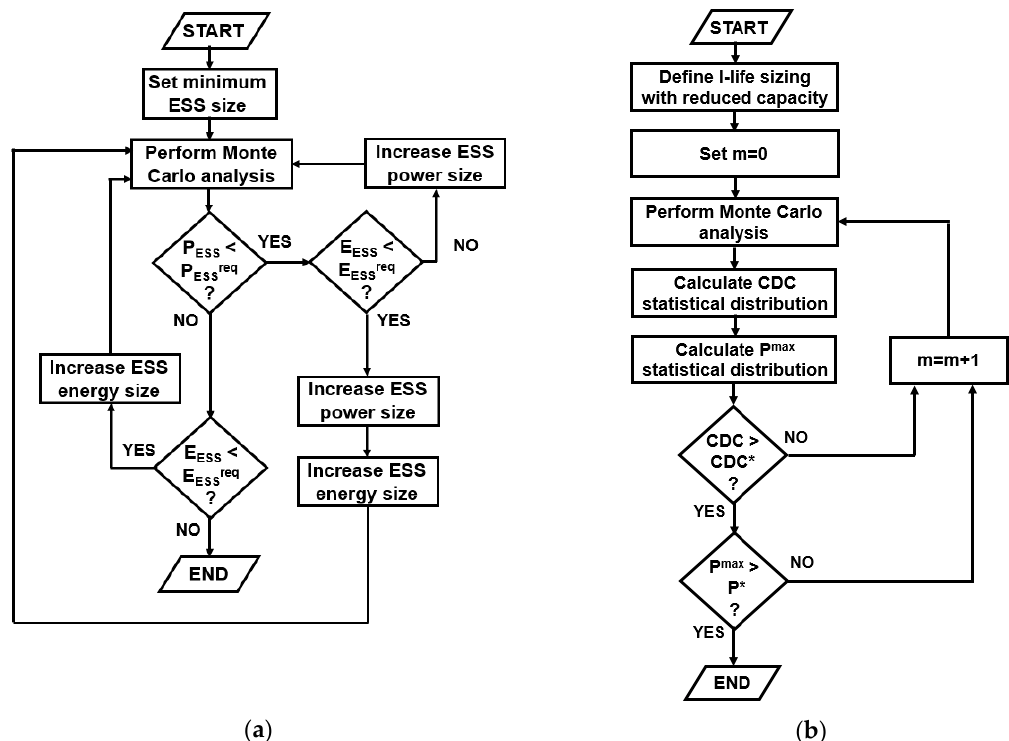
Figure 6. ( a ) Block diagram of the ESS sizing procedure for single o clustered CSs; ( b ) Block diagram of the equivalent ESS sizing in II-Life technology.